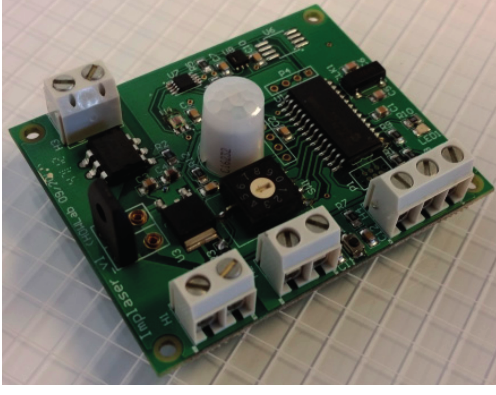
Figure 7. Electronic